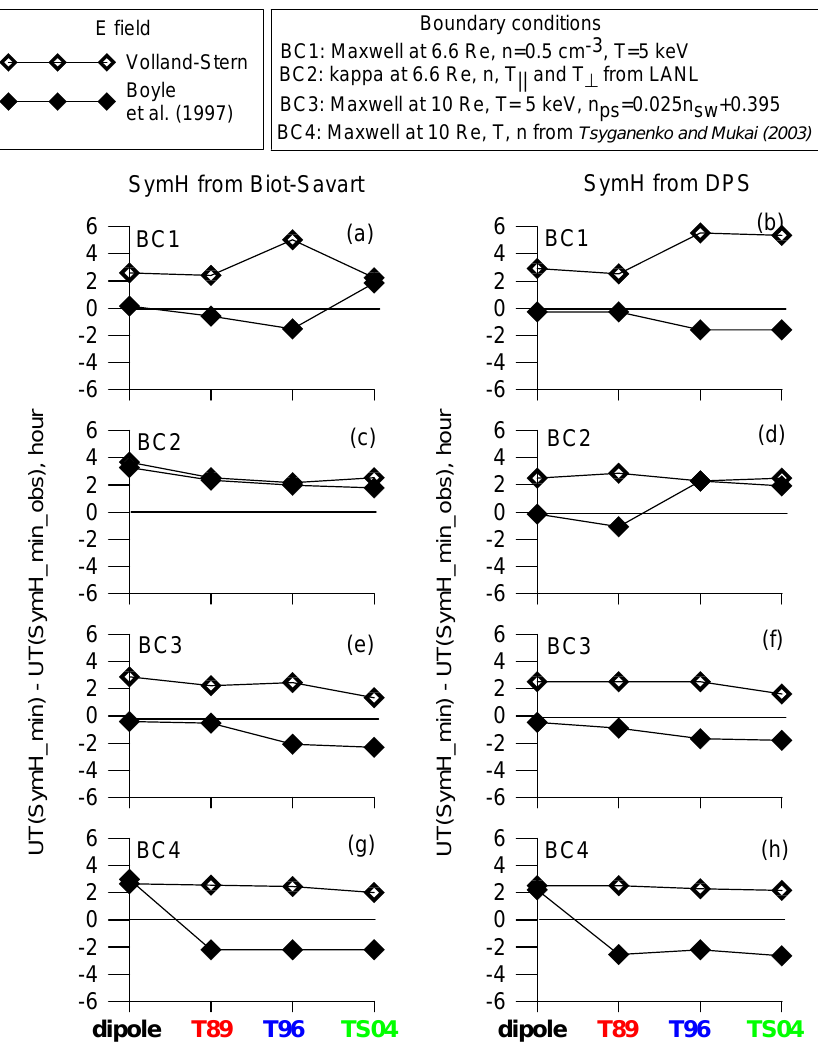
Fig. 14. UTs of the minimum SymH* values of the modeled SymH* profiles shown in Figs. 8 and 9 during 6–7 November 1997 storm in terms of the difference 1 UT SymH (see the